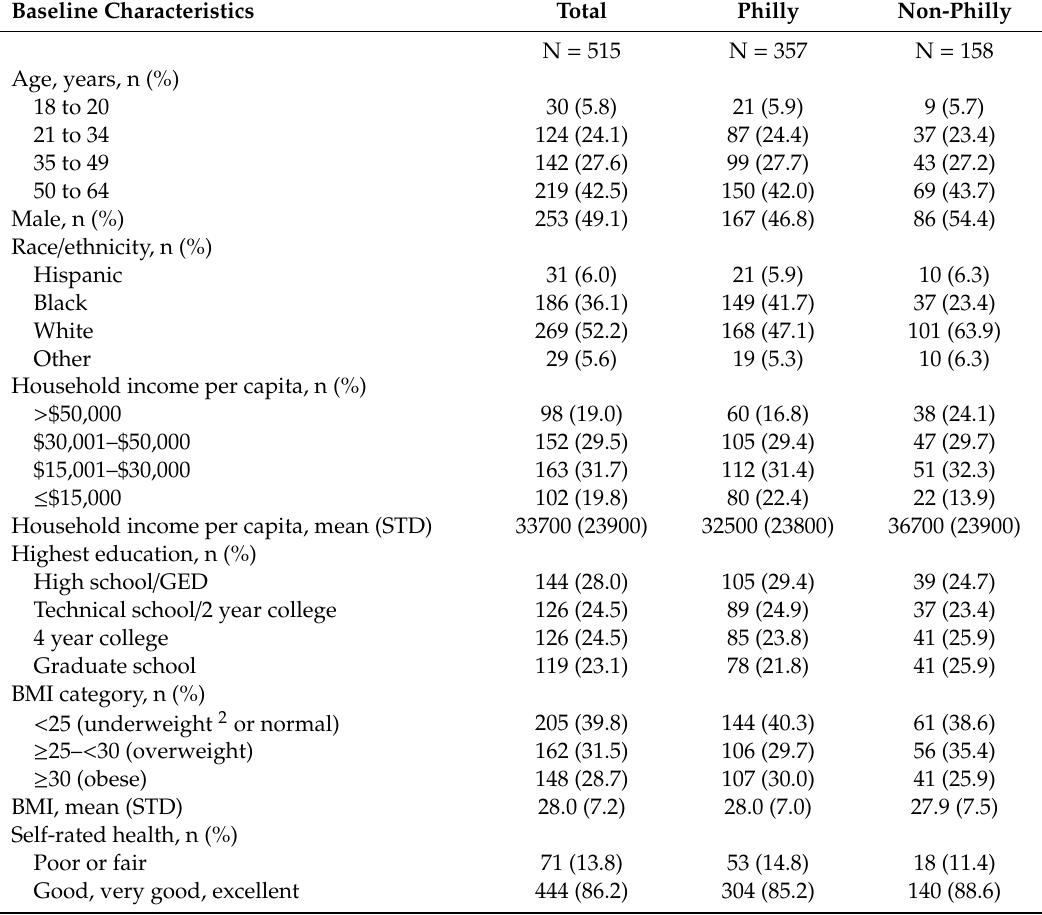
Table 1. Baseline characteristics of participants who responded to the baseline survey before 15 January 2017 and the one-year follow-up survey 1 , N =